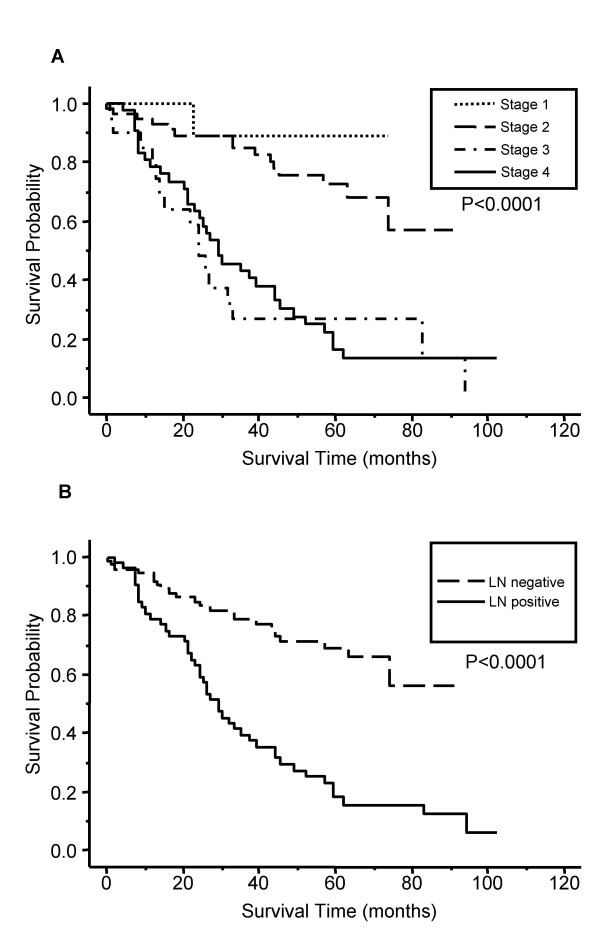
Kaplan-Meier survival curves of the TMA study population. The traditional clinicopathological prognostic factors for colorectal carcinoma, TNM stage, (A), and lymph node metastasis, (B), correlate with survival. Both significant at p < 0.0001.